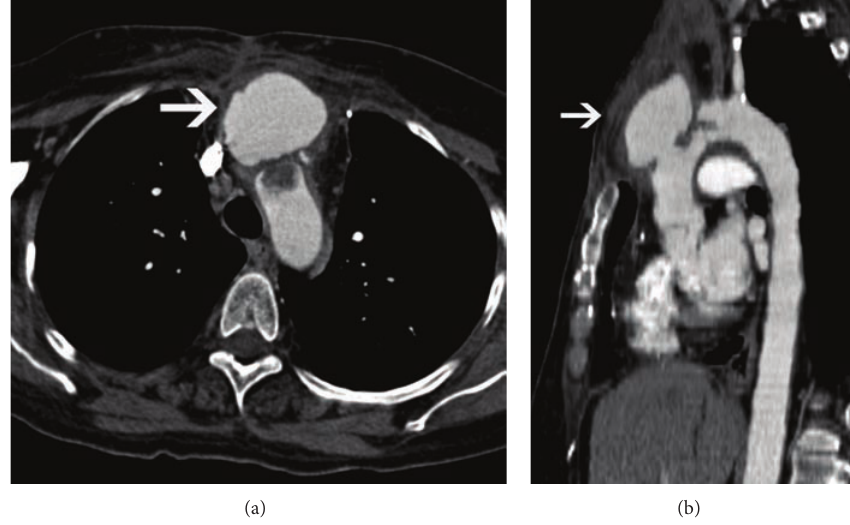
Figure 17: Mycotic aneurysm—(a) axial postcontrast CT scan of a 72-year-old male shows a large saccular pseudoaneurysm (arrow) arising from the anterior aspect of the distal ascending aorta, which is anteriorly eroding the sternum. (b) Sagittal postcontrast CT scan in the same patient shows the focal mycotic pseudoaneurysm (arrow) that is arising from the anterior aspect of ascending aorta and eroding the anterior